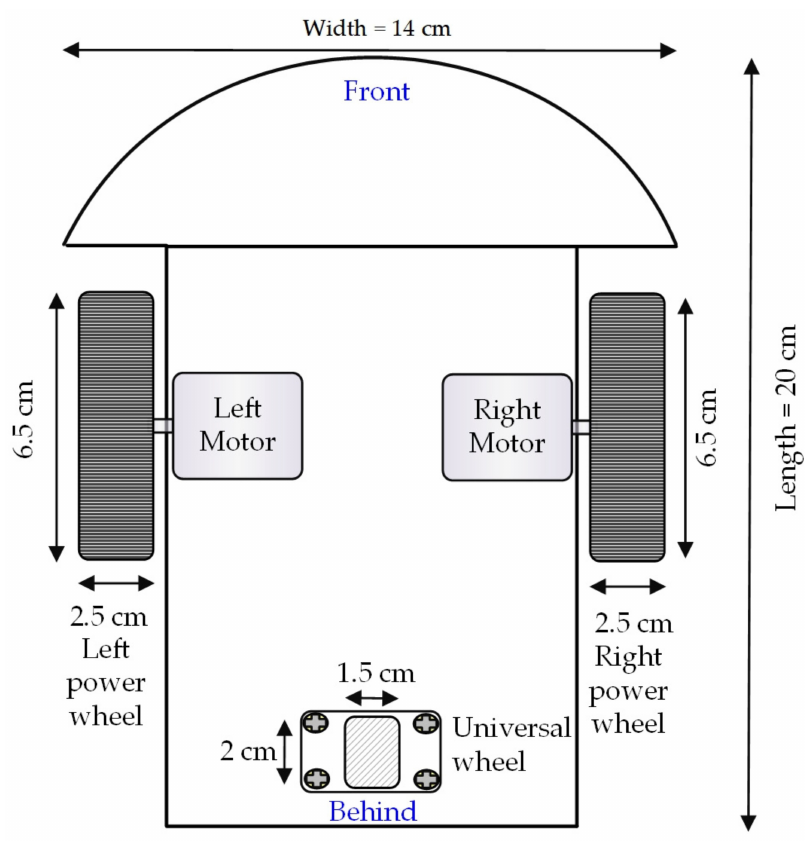
Figure 1. Arrangement of wheels of the self-driving electric mobile